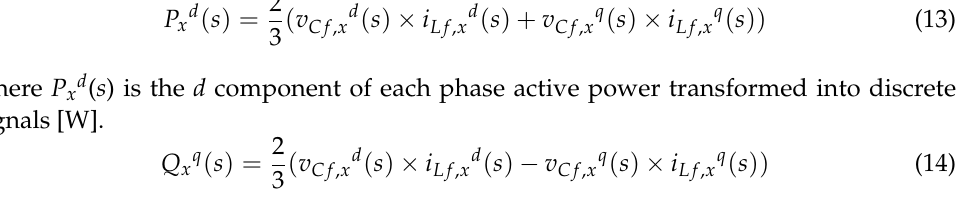
Figure 7. Modeling of single-phase power controller.